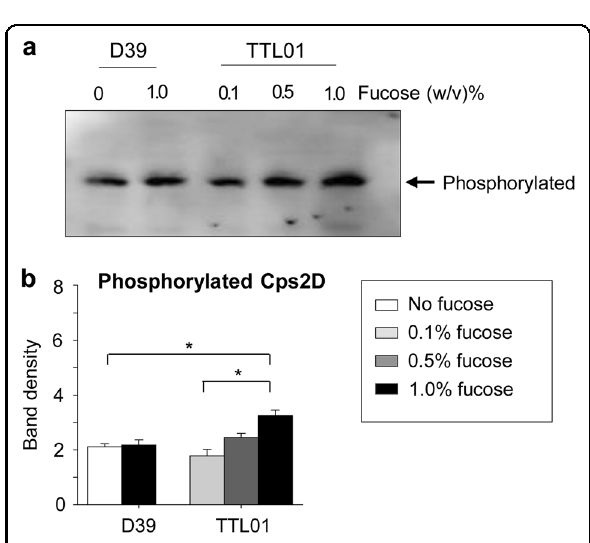
Fig. 3 SpAdK increases phosphorylation of Cps2D. a Pneumococcal lysates were subjected to Phos-tag TM SDS-PAGE and western blotting with anti-Cps2D to compare phosphorylation levels of Cps2D between S. pneumoniae D39 WT and TTL01 strains. The data are representative of three independent experiments. b ImageJ was used for densitometry analysis and to determine the differences in phosphorylated Cps2D levels between D39 WT and TTL01 strains. One-way ANOVA was used for statistical analysis (* P ≤ 0.05 and ** P ≤